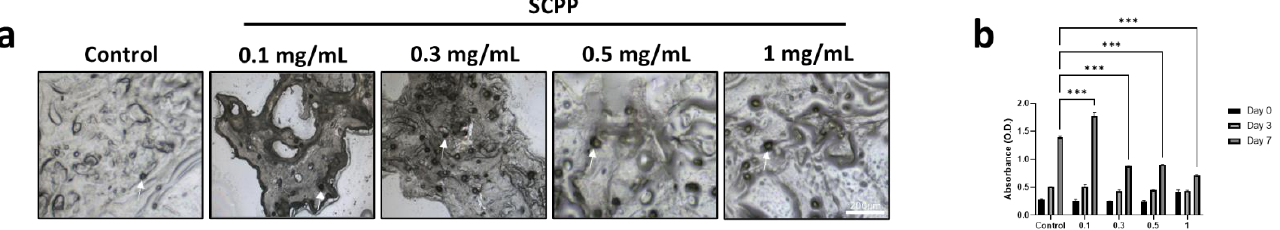
Figure 7. ( a ) Raman microscopy confocal images of scaffolds printed with cells. Cells are dispersed throughout the scaffolds homogenously. White arrows indicate cells embedded on the scaffold surface. ( b ) Cell proliferation of 3D printed cell-based scaffolds over 7 days. *** p ≤ 0.001.